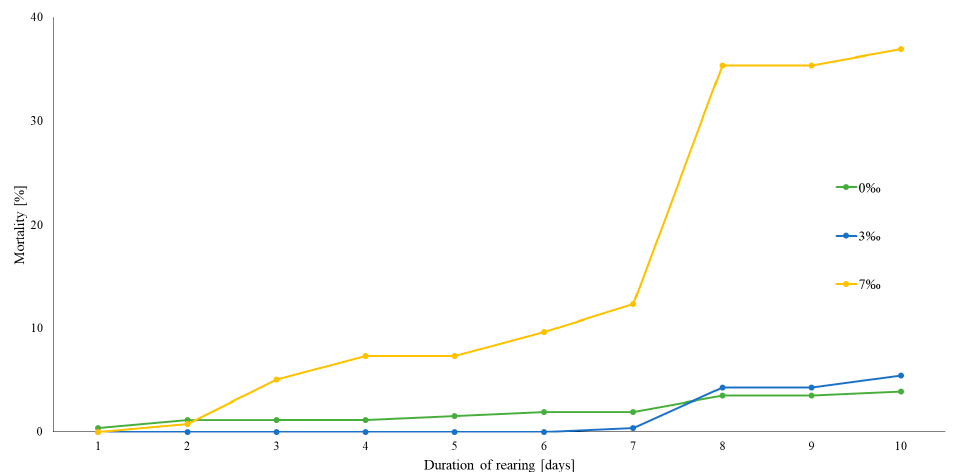
Figure 1. Cumulative mortality of pike fry during 10 days of the experiment. The experiment was conducted in rectangular glass aquarium tanks with a capacity of 25 dm 3 (n = 2 per each group). Each tank had a filter and its own water pump with a separated water cycle. The density of fish in the aquarium was 10 fish/dm 3 and the water temperature was 15 °C. The fish were fed with commercial Artemia Premium Cysts three times per day.